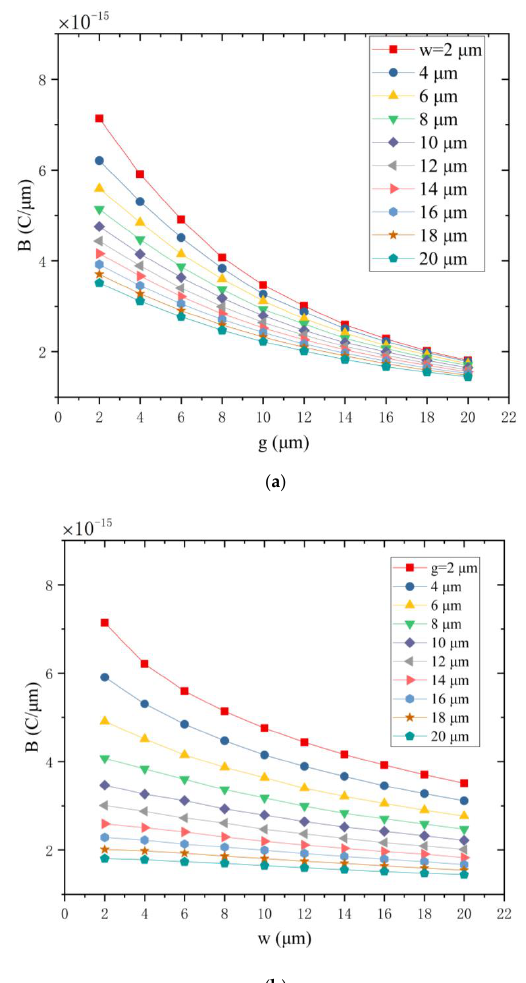
Figure 5. The relationship among parameter B, g and w. ( a ) The parameter B versus the electrode gap(g) under different electrode widths. ( b ) The parameter B versus the electrode width (w) under different electrode gaps.